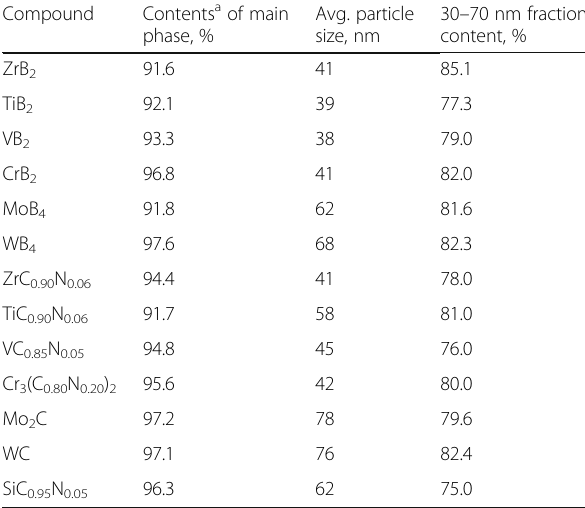
Table 1 Main characteristics of nanopowders of borides and carbides Compound